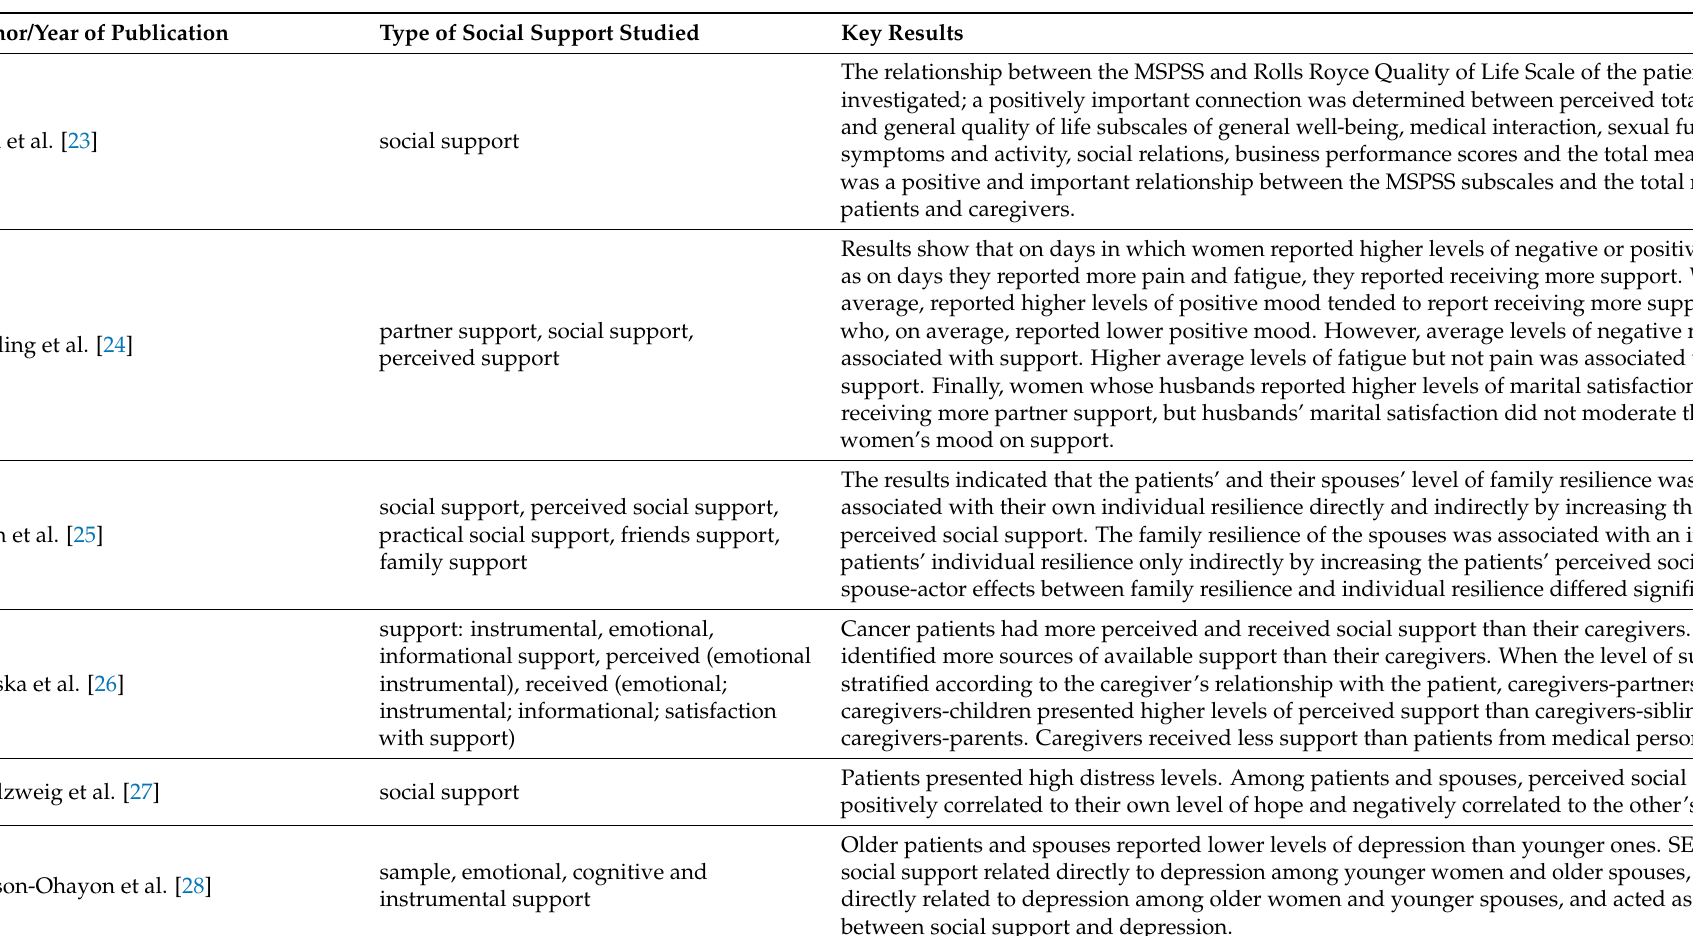
Table 2. Social support studied and key findings of the studies included in the